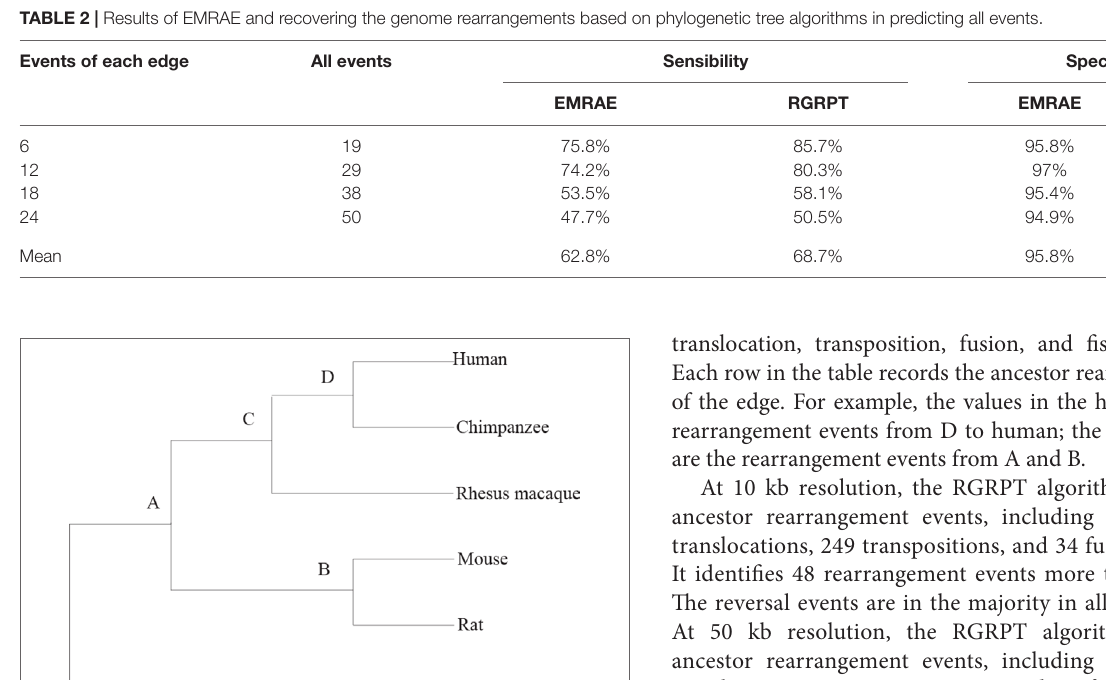
algorithm. The rearrangement events identified in the rat